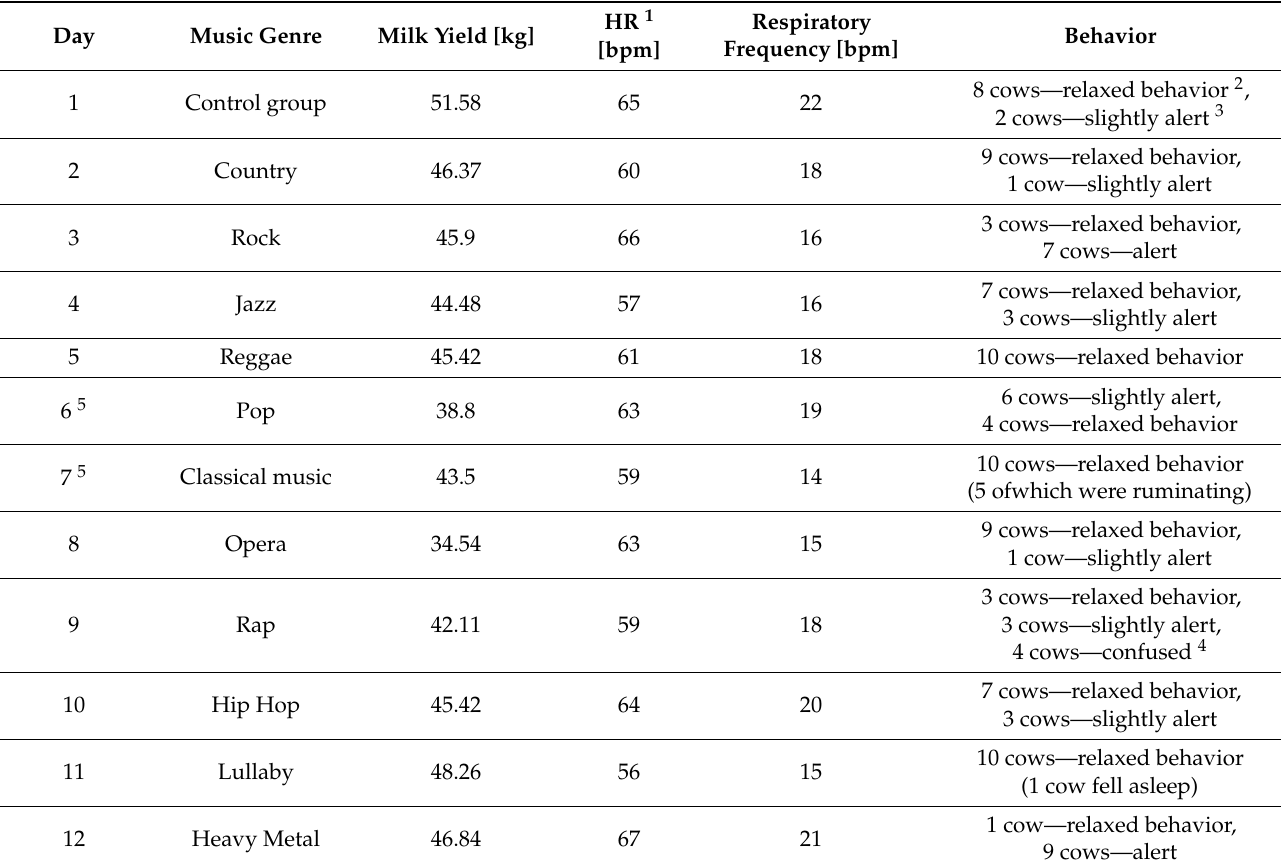
Table 2. Influence of the music genre on basic life parameters, milk yield and cow behavior (N = 10). Own elaboration based on